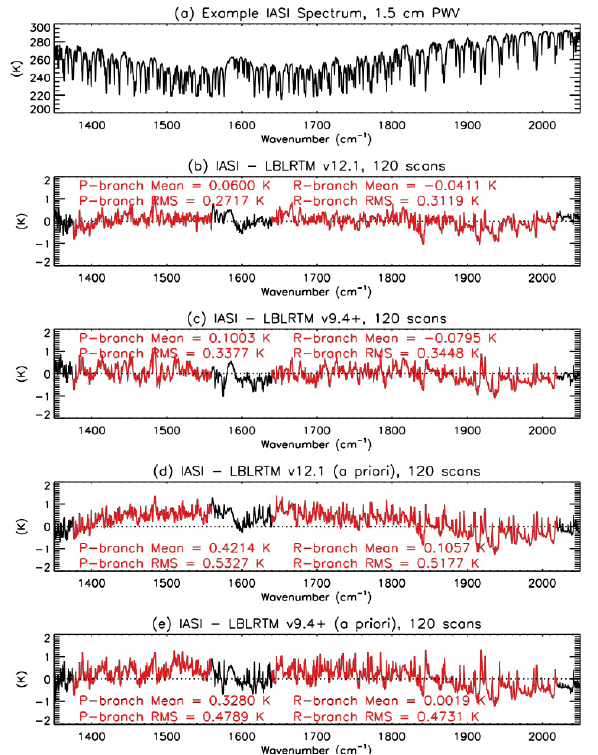
Fig. 14. (a) IASI-observed brightness temperature spectrum in the ν 2 band of H 2 O for an example profile with 1.5cm PWV. (b) Mean of the final (a posteriori) brightness temperature residuals for 120 spectra using LBLRTM v12.1. (c) Mean of the final brightness tem- perature residuals for 120 spectra using LBLRTM v9.4 + . (d) Mean of the a priori brightness temperature residuals for 120 spectra us- ing LBLRTM v12.1. (e) Mean of the a priori brightness tempera- ture residuals for 120 spectra using LBLRTM v9.4 + . The P- and R-branch H 2 O retrieval windows are highlighted in red. Note that the RMS due to instrument noise alone in the P-branch is 0.041K and in the R-branch is 0.088K.